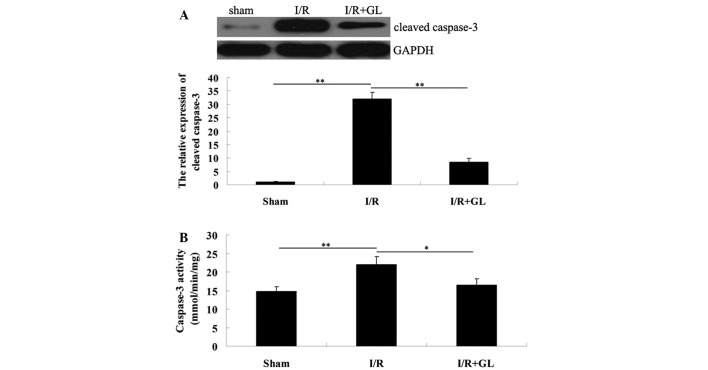
(A) Western blot analysis was performed to examine the protein level of cleaved caspase-3 in the three groups. GAPDH served as an internal control. (B) Activity of caspase-3 in the renal tissue was determined in each group using a caspase-3 colorimetric assay kit. *P<0.05 and **P<0.01. I/R, ischemia-reperfusion; Gl, glycyrrhizin.